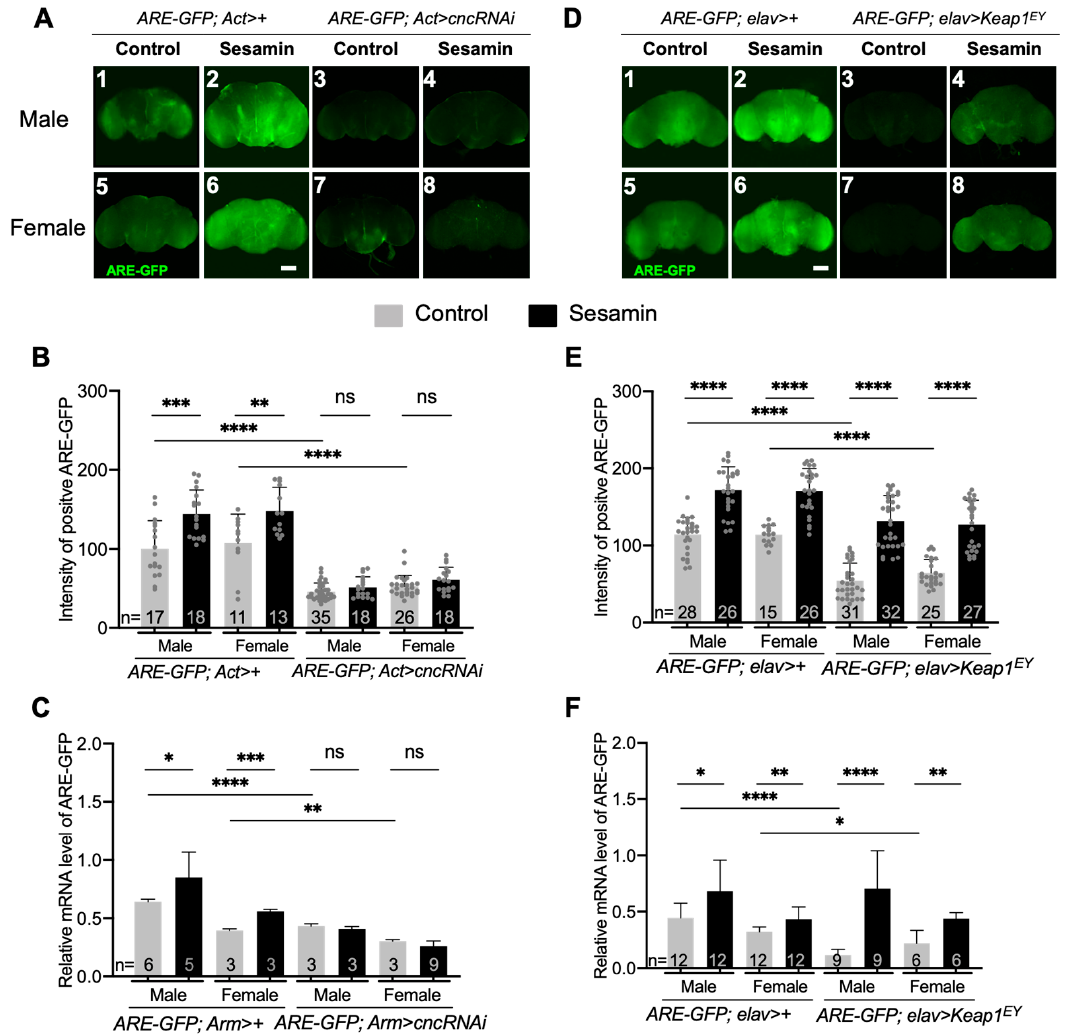
Figure 2. Reduction of sesamin-induced ARE-GFP expression by depletion of mRNA encoding a Nrf2/Cnc transcription factor or by ectopic overexpression of Keap1 . ( A , D ) GFP fluorescence in brains from adults harboring ARE-GFP reporter (ARE). Brains were prepared from male flies ( A1 – A4 , D1 – D4 ) or female flies ( A5 – A8 , D5 – D8 ). ( A1 , A2 , A5 , A6 ) Brains from control flies with ARE-GFP ( ARE-GFP ; Act > + ) fed on fly diet ( A1 , A5 ) or the diet supplemented with 2 mg/mL sesamin ( A2 , A6 ). ( A3 , A4 , A7 , A8 ) Brains from flies harboring depletion of cnc in all brain cells using Gal4 driver, Act-Gal4 and ARE-GFP ( ARE-GFP ; Act > cncRNAi ) fed on the fly diet ( A3 , A7 ), or the diet with 2 mg/mL sesamin ( A4 , A8 ). ( D1 , D2 , D4 , D5 ) Brains from control flies with ARE-GFP ( ARE-GFP ; elav > + ) fed on fly diet ( D1 , D5 ) or the diet supplemented with 2 mg/mL sesamin ( D2 , D6 ). ( D3 , D4 , D7 , D8 ) Brains from flies harboring ectopic overexpression of Keap1 encoding an inhibitor of Nrf2/Cnc using a pan-neuronal Gal4 driver, elav-Gal4 and ARE-GFP ( ARE-GFP ; elav > Keap1 EY ) fed on the diet ( Dc 3, D7 ), or the diet with 2 mg/mL sesamin ( D4 , D8 ). ( B , E ) Quantification of GFP intensity of brains from adults harboring ARE-GFP, with or without ubiquitous depletion of cnc ( ARE-GFP ; Act > + , ARE-GFP ; Act > cncRNAi ) ( B ), or brains harboring ARE-GFP with or without pan-neuronal expression of Keap1 from adults ( ARE-GFP ; elav > + , ARE-GFP ; elav > Keap1 EY ) ( E ), fed with or without 2 mg/mL sesamin. The intensity of the ARE-GFP fluorescence in adult brains (n ≥ 11) was calculated by Image J for each condition. ( C , F ) Quantification of GFP mRNA of brains from adults harboring ARE-GFP with or without ubiquitous depletion of cnc ( ARE-GFP ; Act > + , ARE-GFP ; Act > cncRNAi ) ( C ), or brains harboring ARE-GFP with or without pan-neuronal expression of Keap1 ( ARE-GFP ; elav > + , ARE-GFP ; elav > Keap1 EY ) ( F ), fed with or without 2 mg/mL sesamin. The relative GFP mRNA level was quantitated by qRT-PCR using total RNA from 40–50 heads for each condition. Scale bars represent 100 µ m in the adult brain. ns not significant, * p < 0.05, ** p < 0.01, *** p < 0.001, **** p < 0.0001, Student’s t